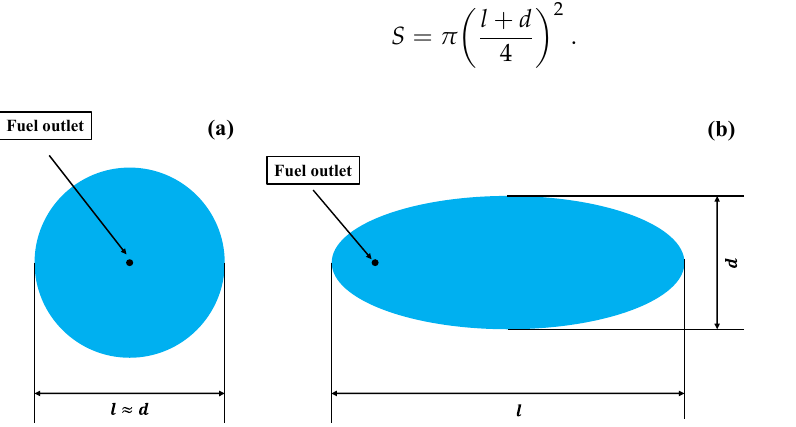
Figure 2. Approximate shape of spread area under non-ignited conditions. ( a ) On the flat surface; ( b ) On the inclined surface.